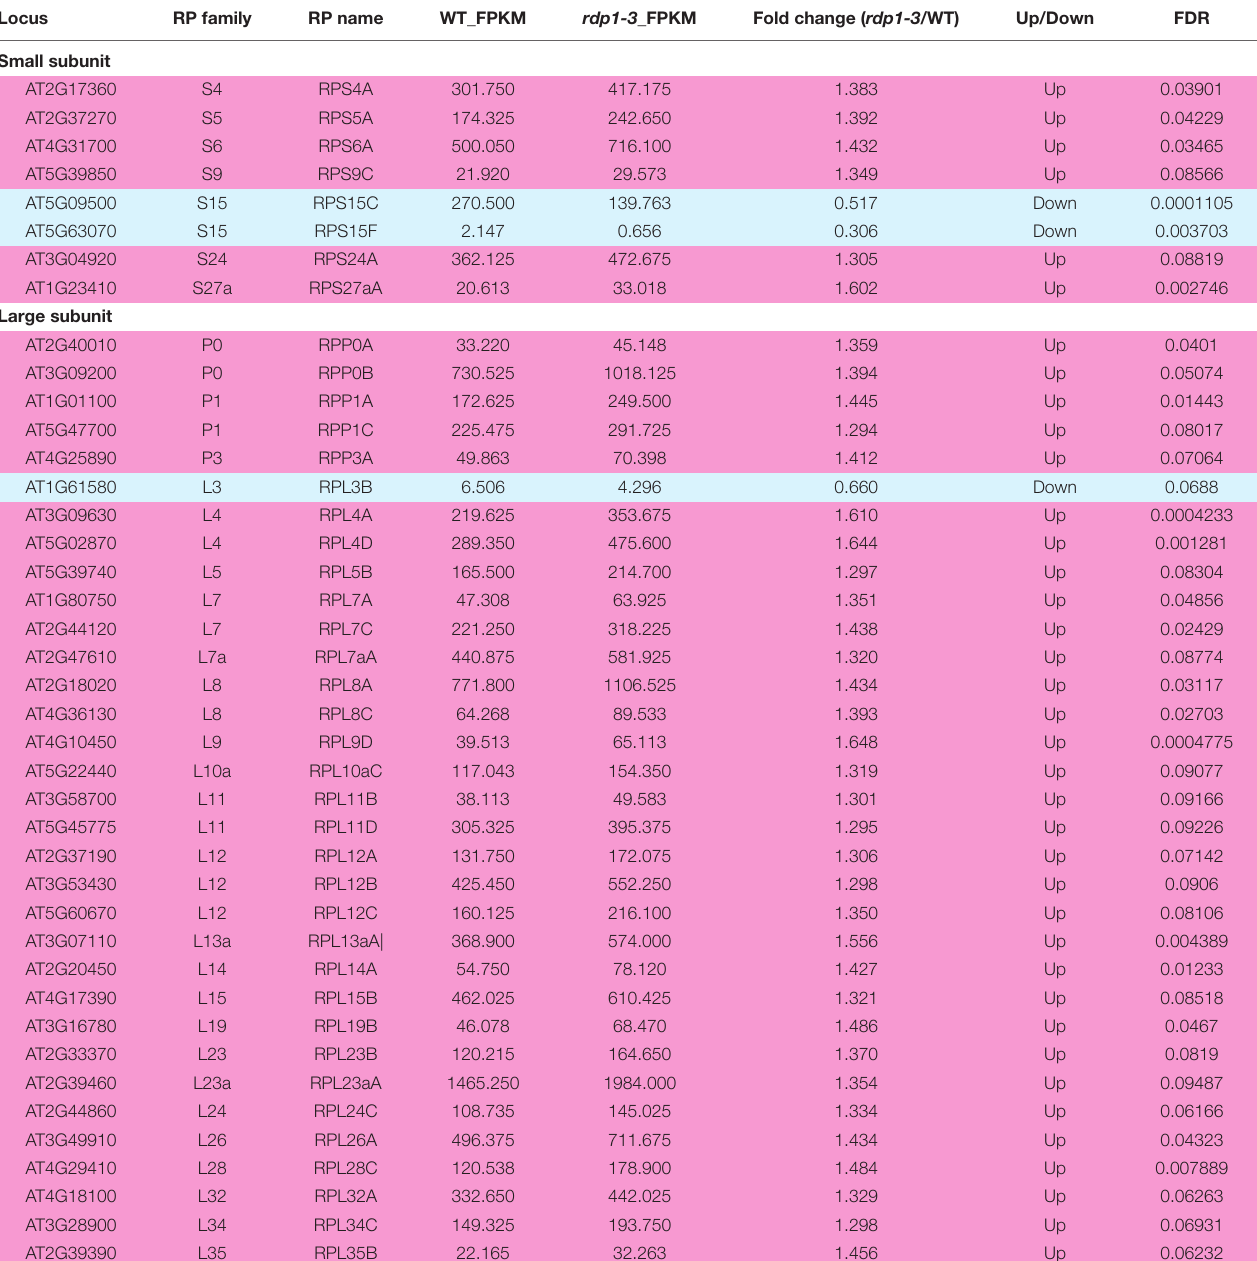
TABLE 1 | DEGs from ribosomal small and large subunit-related genes (FDR < 0.1). Locus RP